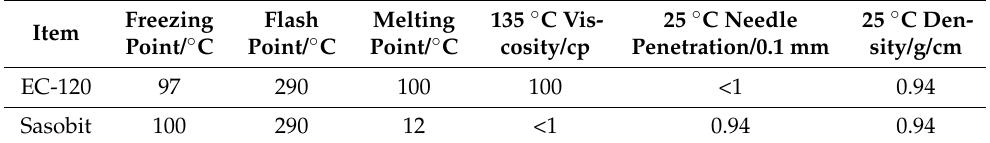
Table 4. Basic properties of EC-120 agent and Sasobit.